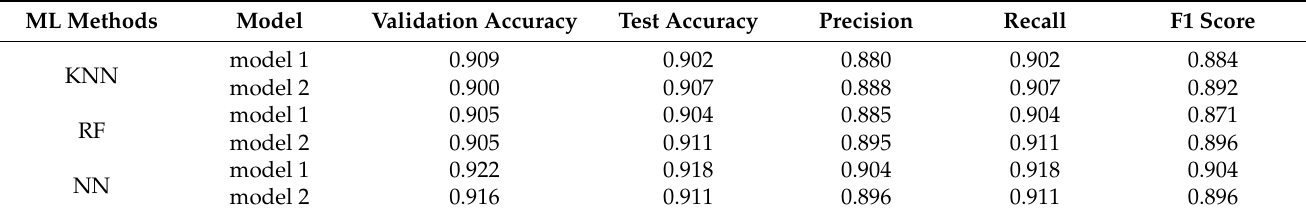
Table A2. Accuracy in each predictive model (PHQ-9 used item 1 to item